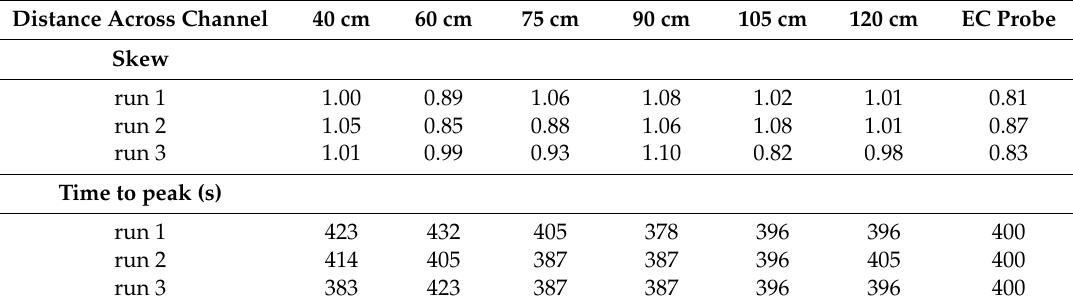
Table 3. Neerigen Brook Reach 2. Tracer results for skewness and time to peak. Distance Across Channel